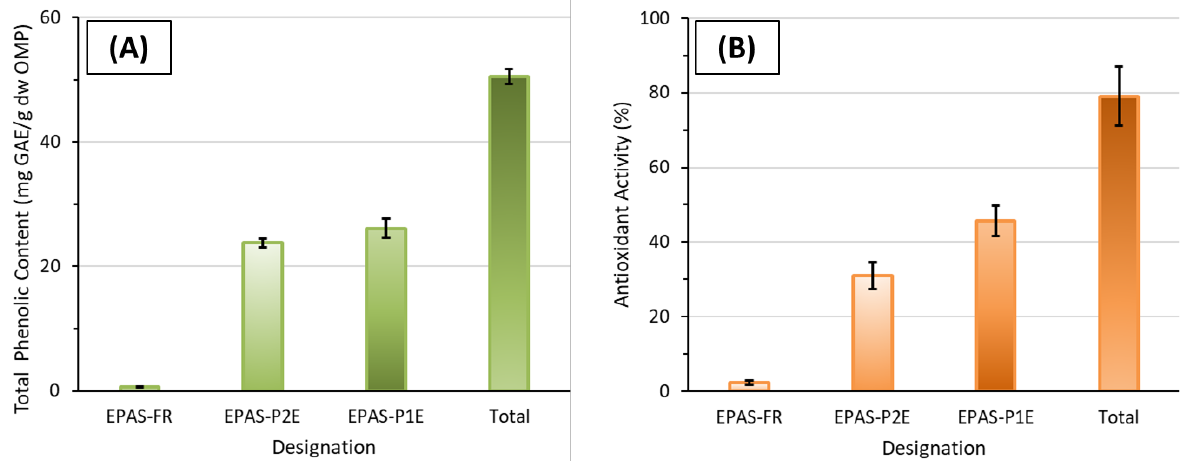
Figure 6. Distribution of the total phenolic content ( A ) and the total antioxidant activity ( B ) among different fractions (EPAS-FR, EPAS-P2E, and EPAS-P1E) of OMP extracted samples obtained con- sidering extraction optimized conditions (EPAS-FR—Extracted Phenolic Antioxidants during the Fat Removal procedure; EPAS-P1E—Extracted Phenolic Antioxidants during the primary extraction; EPAS-P2E—Extracted Phenolic Antioxidants from the secondary extraction procedure).